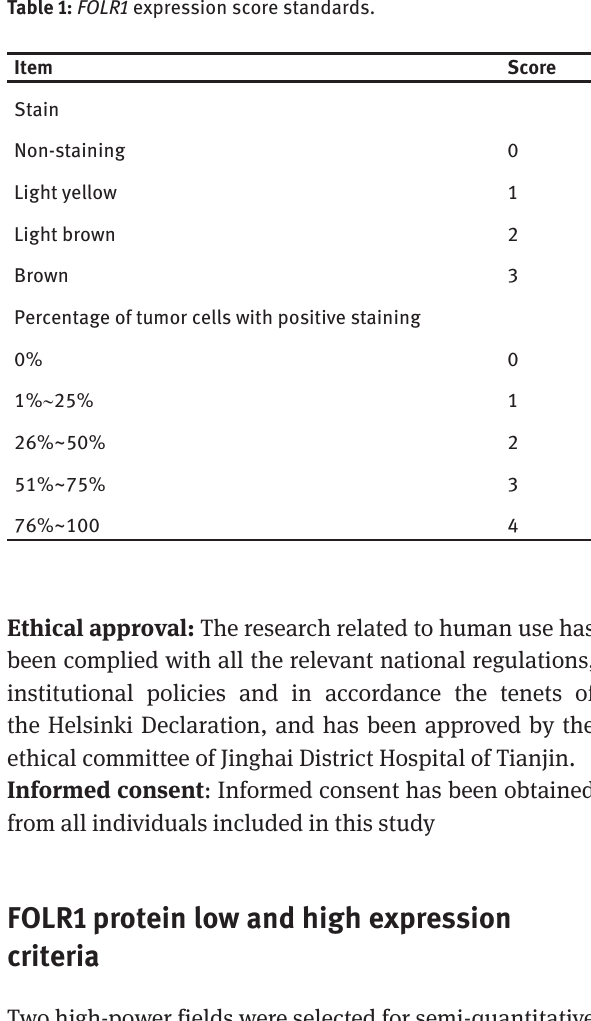
Table 1: FOLR1 expression score